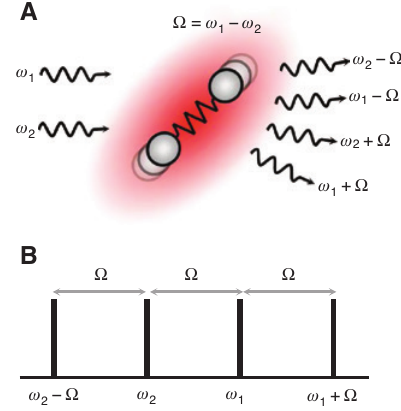
Figure 6: Dual-color coherent Raman scattering (CRS). (A) Two fields with frequencies ω inducing a vibrational coherence at Ω = ω four different signal fields. (B) CRS gives rise to signal fields